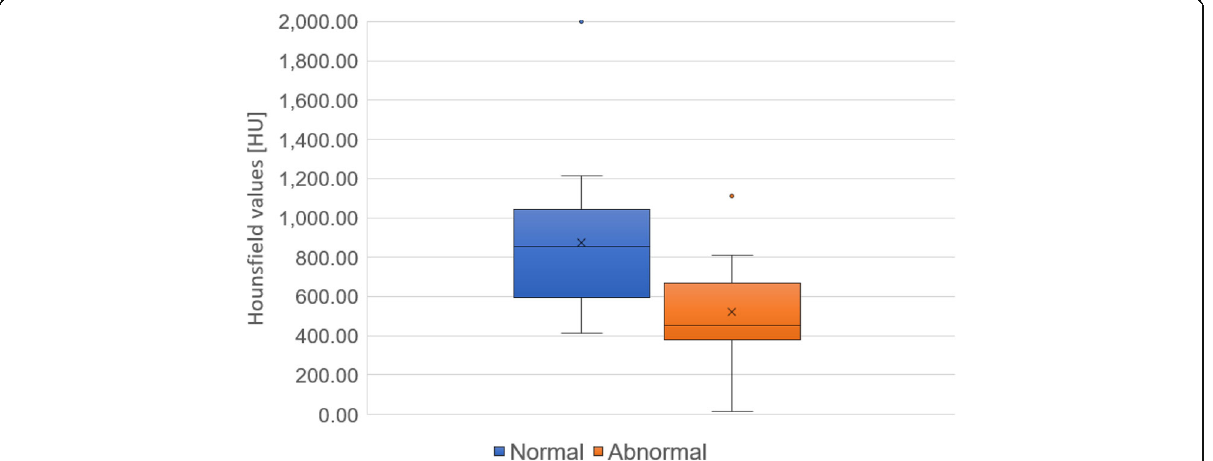
Fig. 4 Cancellous bone densities in the normal and abnormal groups of women are shown. Cancellous bone density is significantly higher in the normal group than in the abnormal group